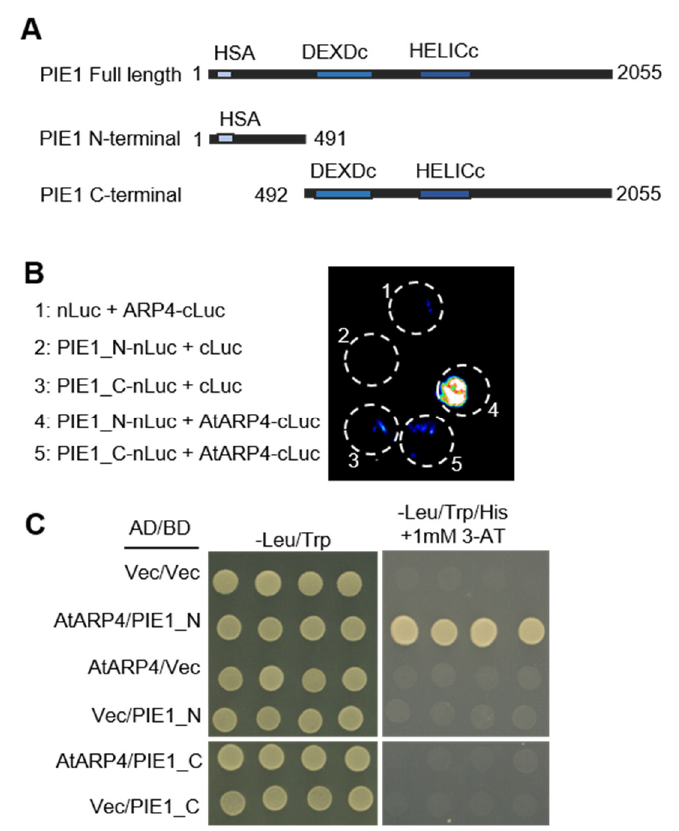
Figure 2. AtARP4 physically interacts with PIE1 in vivo. ( A ) Schematic diagram of truncated forms of PIE1. ( B ) Split luciferase complementation assays for interaction between AtARP4 and PIE1 in vivo. The indicated proteins were transiently expressed as fused to the N-terminal or the C-terminal part of the luciferase protein (nLuc or cLuc, respectively) in N. benthamiana leaves. Three independent biological replicates were performed, and one representative result is shown. ( C ) Determination of in vitro interaction between AtARP4 and PIE1 using yeast two-hybrid system. Two truncated forms of PIE1, the N- and C- terminal region were performed. BD, GAL4 binding domain; AD, GAL4 activation domain. “Vec” indicates the empty vector, used as the control.